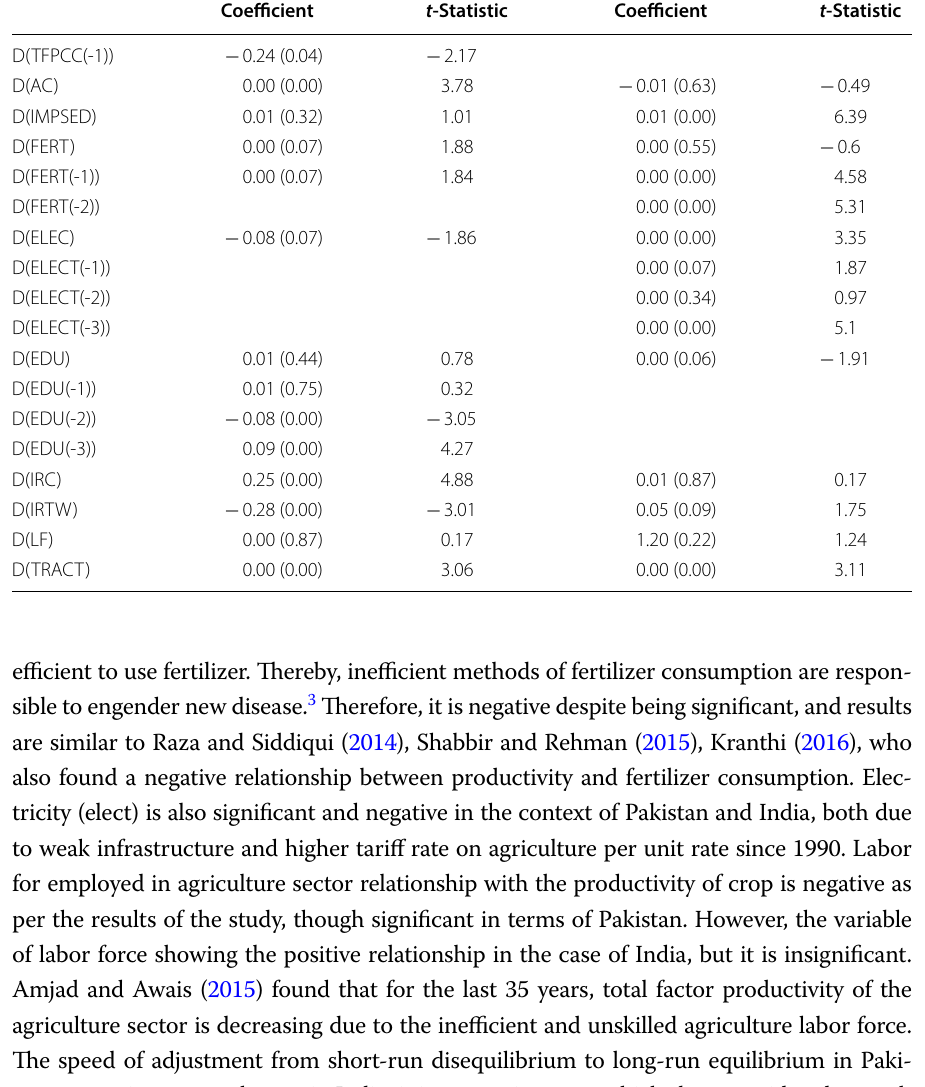
Table 4 Short-run vector error correction model Short-run error correction model